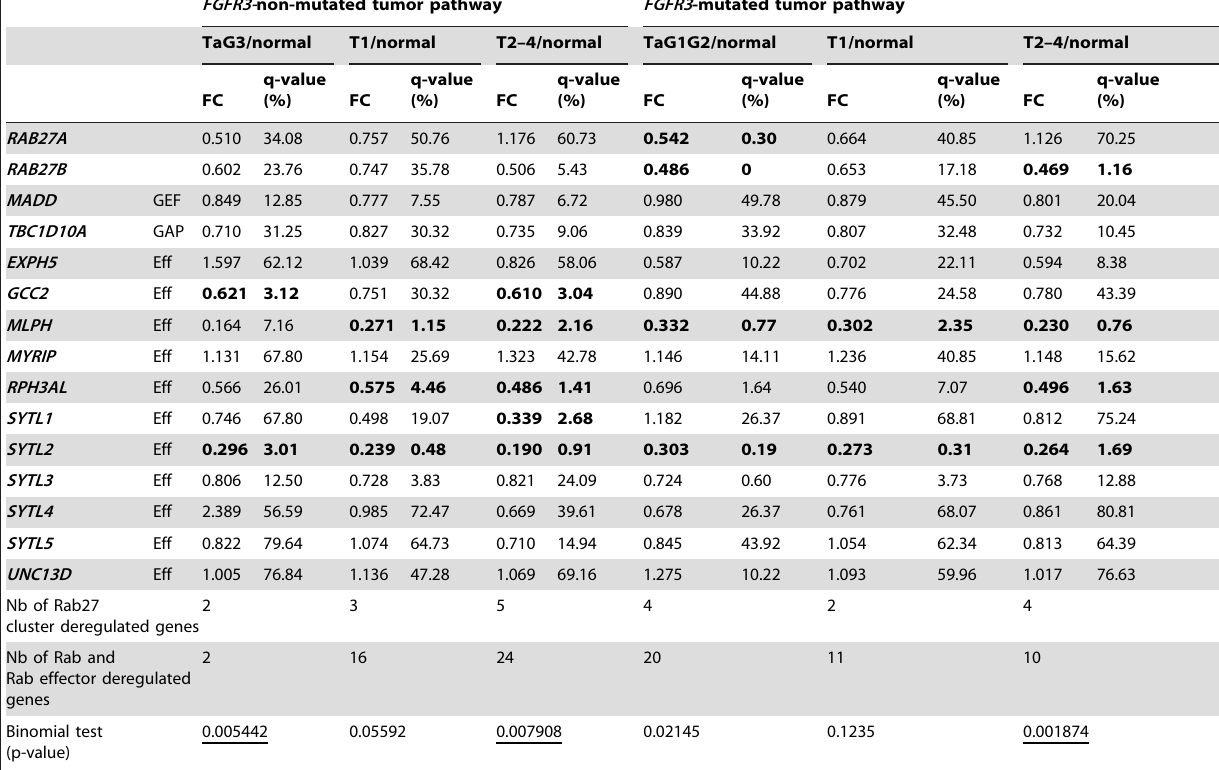
FGFR3- non-mutated tumor pathway FGFR3 -mutated tumor